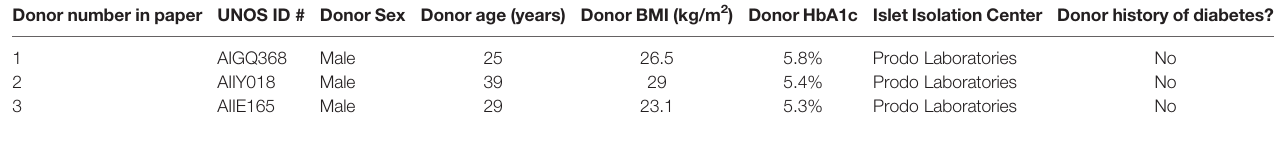
TABLE 1 | Information from Donors used for MT